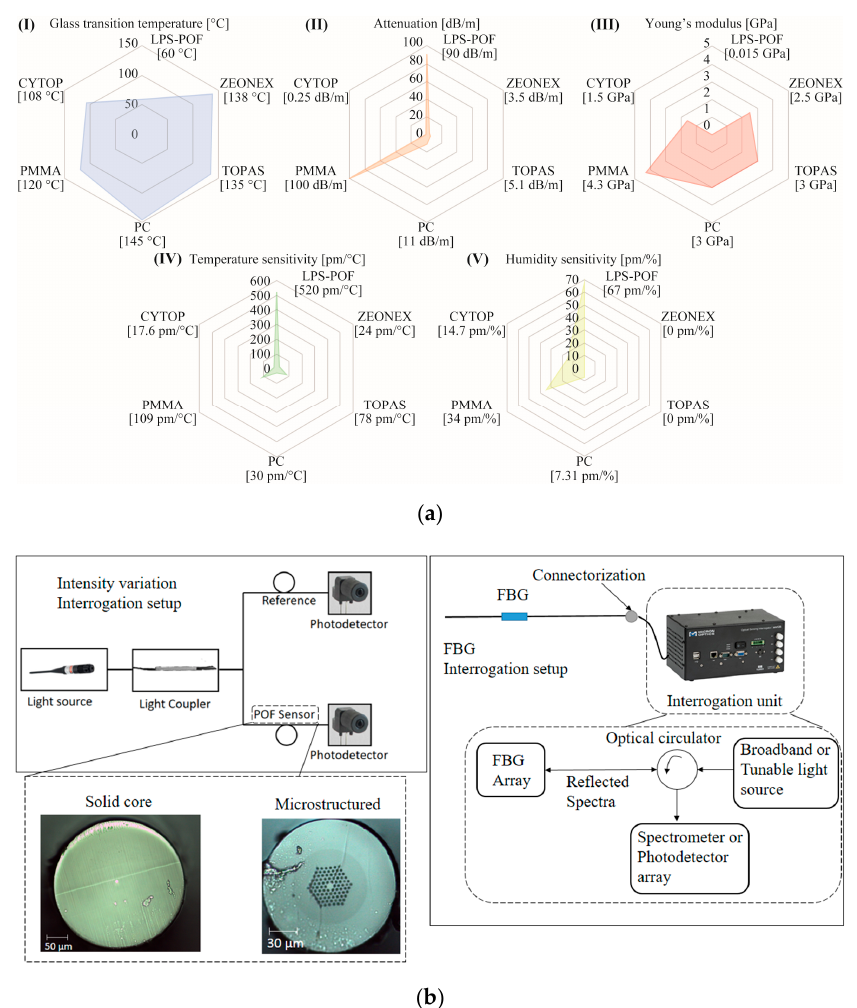
Figure 4. ( a ) Properties of different polymer optical fiber (POF) materials. ( I ) Glass transition temperature, ( II ) optical attenuation, ( III ) Young’s modulus, ( IV ) Temperature sensitivity (considering fiber Bragg gratings (FBGs)) and ( V ) Humidity sensitivity (considering FBGs). ( b ) Interrogation setup for intensity variation-based and FBG sensors. Figure inset shows microscopic images of